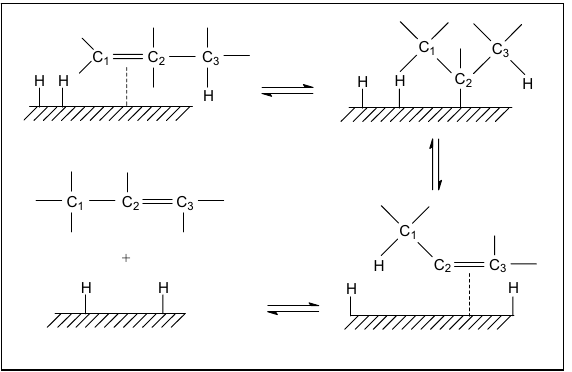
Fig. 1 – Mechanism of formation of geometric and positional isomers in the hydrogenation process (Min